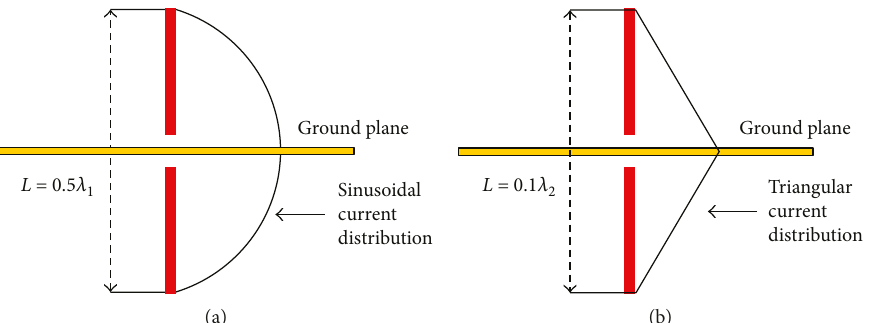
Figure 1: (a) Antenna (length=0.5 λ